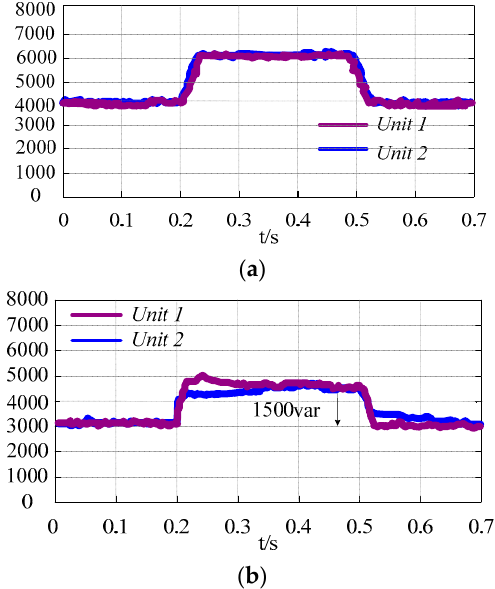
Figure 10. Performance with the communication delay. ( a ) The active power (W); ( b ) The reactive power (var).